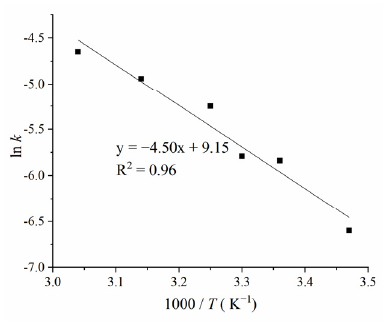
Figure 4. Arrhenius diagram of dissolved UO 2.